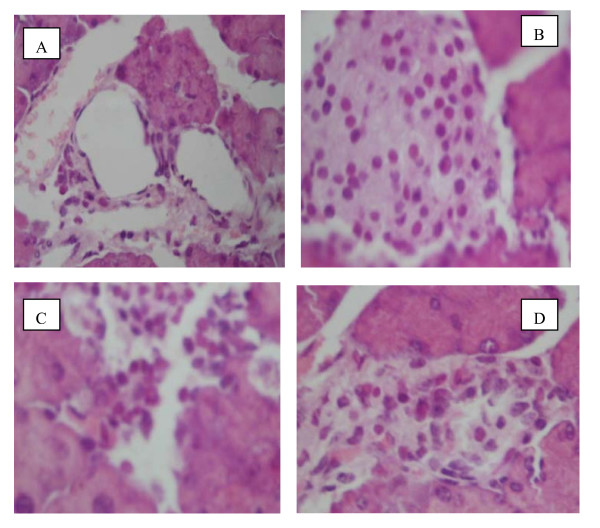
Islet cell death and replication represented by hematoxylin--eosin. The islet cells of diabetic mice of alloxan-treatment (A) showed extensive cell lysis, representing loss of plasma membrane with condensed nuclei and dissolved cytoplasm in wide intercellular spaces. In contrast, the islet cells of CSE(4.0)-fed mice (B) and Xiaoke Pill-treated (D) mice were partly recovered. The islet cells of CSE(2.0)-fed mice was C.